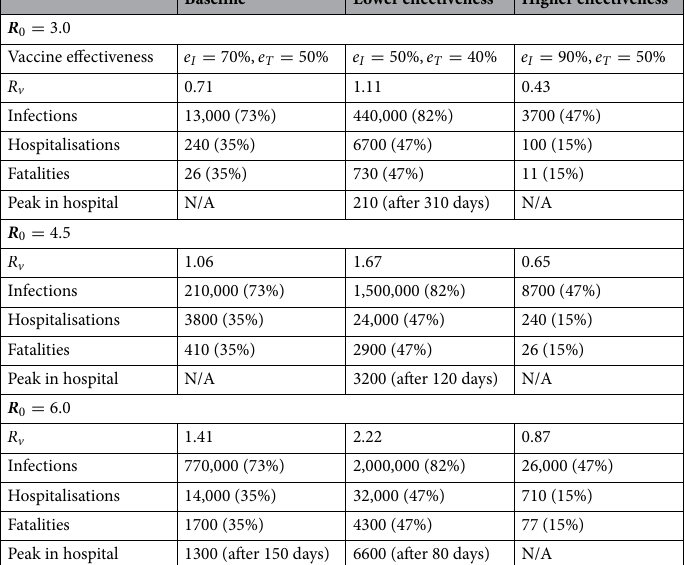
Baseline Lower effectiveness Higher effectiveness R 0 =